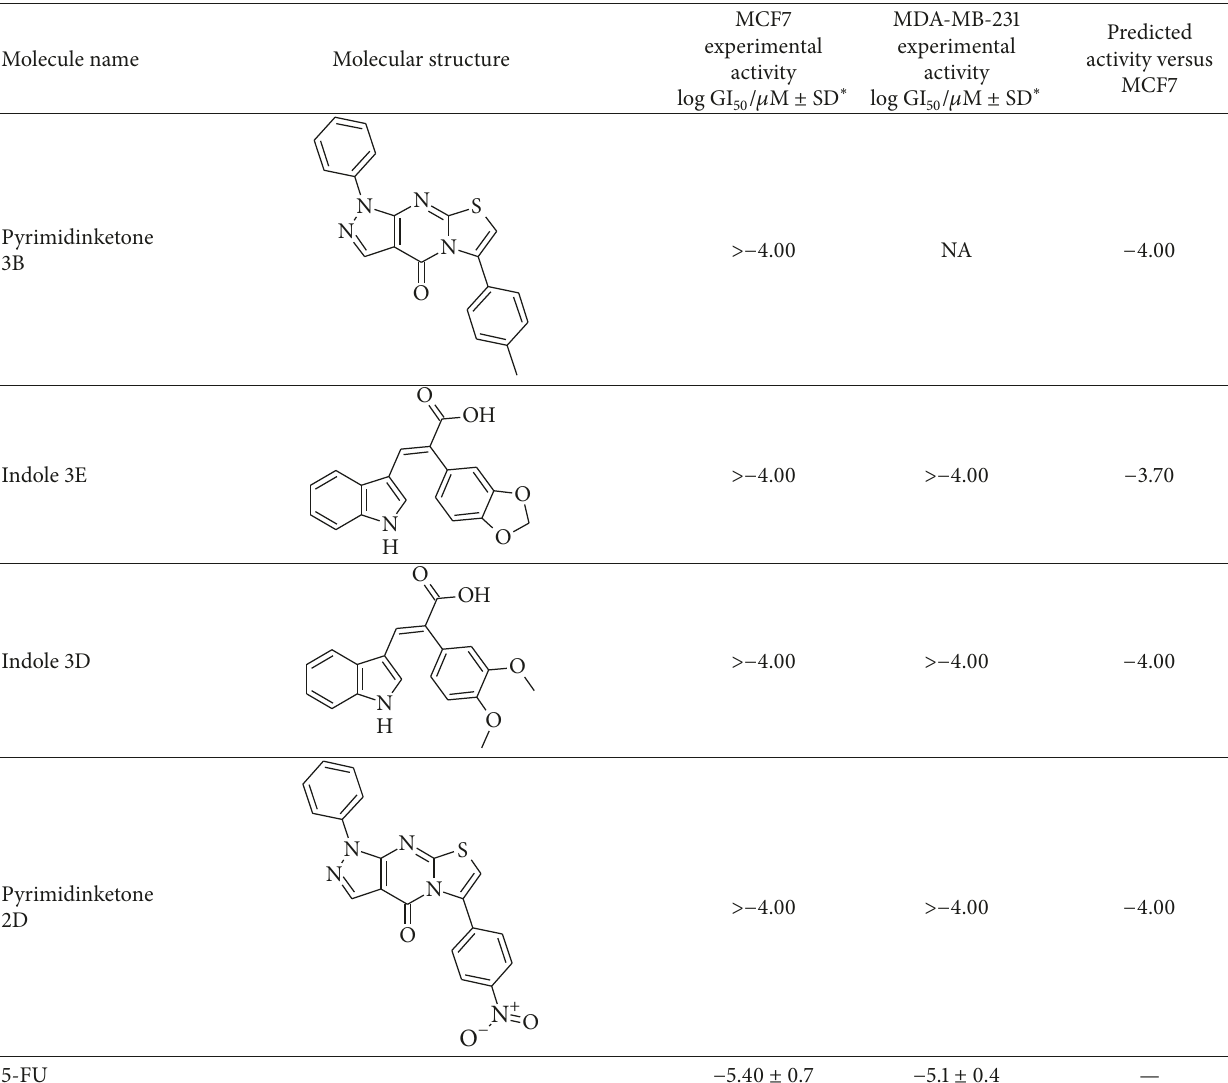
∗ Each value represents the mean ± SD of six to eight wells. NA, not